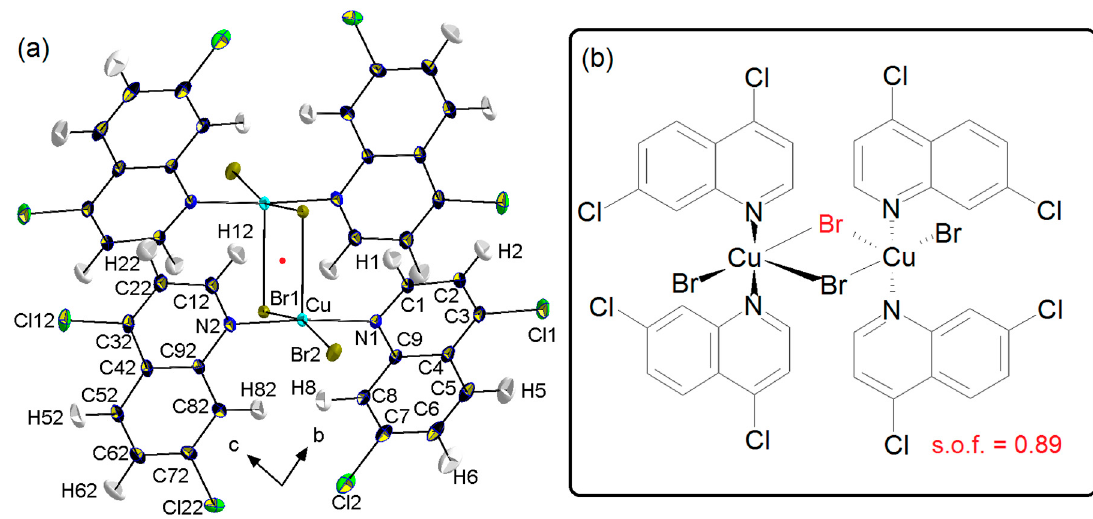
Figure 1. ( a ): Single-crystal X-ray structure of the centrosymmetric CDCQB complex at 100 K, with the atom numbering scheme, as viewed down the a axis. The center of symmetry (red dot) coincides with the center of coordinates. Thermal ellipsoids are drawn at the 50% probability level. Anisotropic displacement parameters were assigned to hydrogen atoms according to the procedure implemented in the Shade [23] server. ( b ): Chemical connectivity of CDCQB. The Br atom drawn in red corresponds to Br(1) and is occupationally disordered with site occupation factor (s.o.f.) of 0.89 (see Section 2).